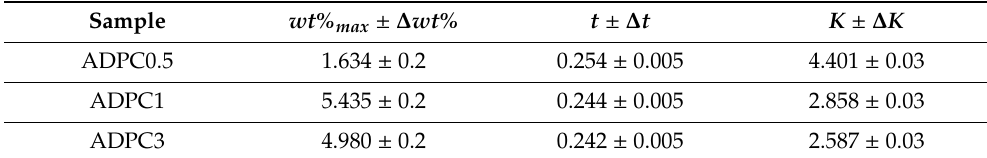
Table 2. Töth equation fitting parameters for the activated samples.